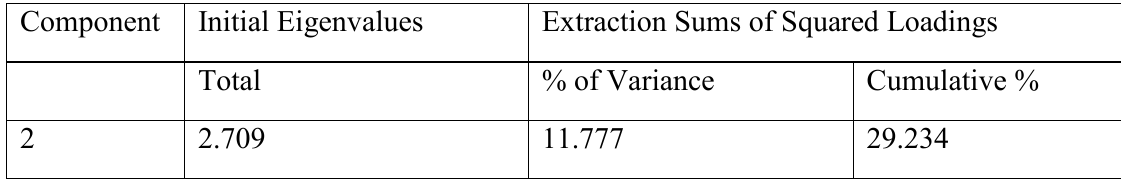
Table 1.41: Variance explained for Transformative Resilience PC2